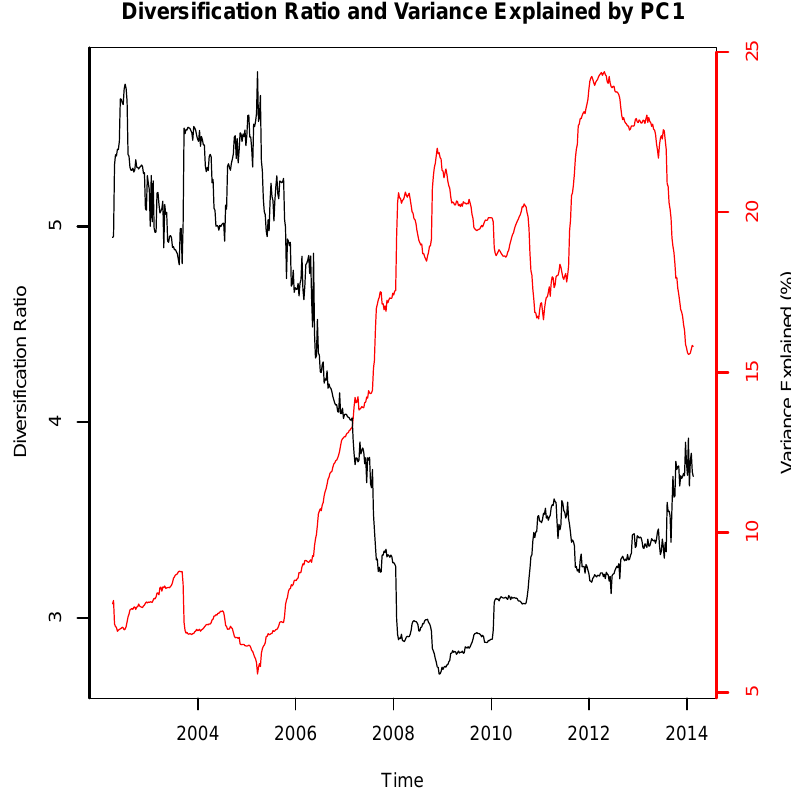
Figure 5. The variance explained by PC1 (right hand axis, red line) and the diversification ratio (left hand axis, black line). The variance explained by PC1 was calculated weekly using a rolling window size of two years (equivalent to 504 trading days). The diversification ratio was calculated using Equation